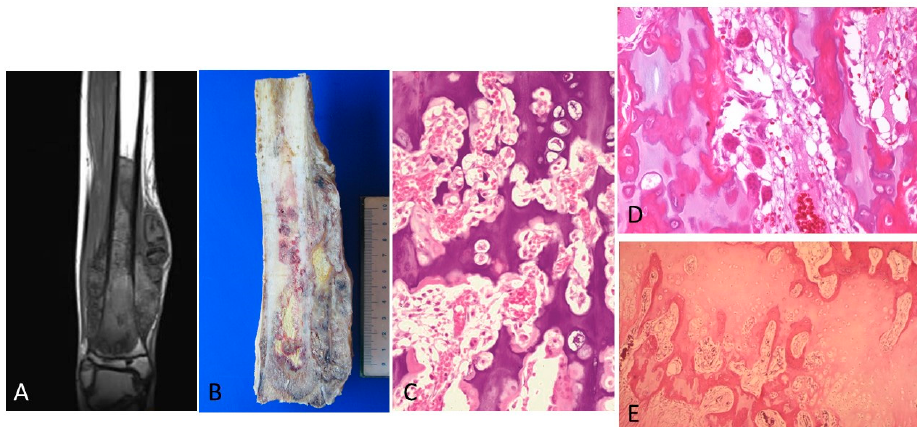
Figure 3. ( A ) MRI showing tumor is in proximity of the physis. ( B ) The corresponding macroscopy is shown. A good correlation can be observed between the radiology and the macroscopy of the osteosarcoma. ( C ) The physis is altered because of the vascular and cell proliferation in zones of the physis in proximity of osteosarcoma (H&E, × 100). ( D ). Intense angiogenesis in the physis is observed. (H&E, × 200). ( E ). A few osteoclasts and osteoblasts are seen in the bone trabeculae in the growth plate. The osteoblasts have a hypertrophic aspect (H&E, ×